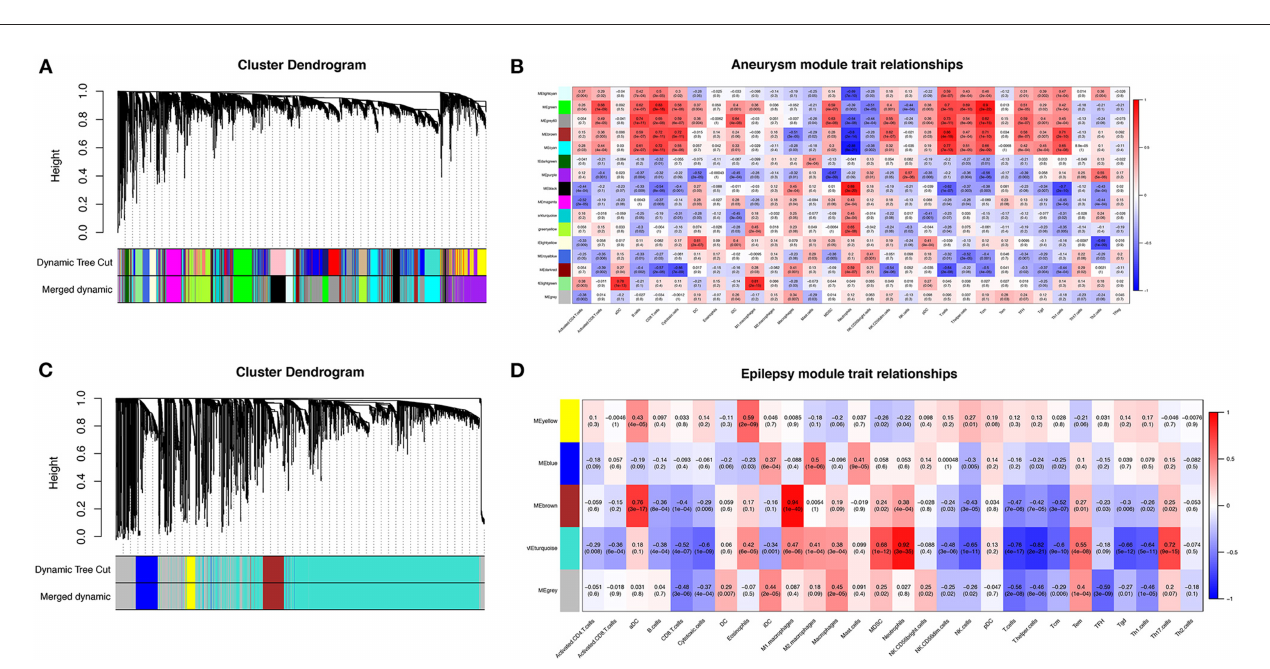
FIGURE7 Weighted gene co-expression network analysis (WGCNA). (A) Cluster dendrogram of co-expression genes in SAH. (B) Module–trait relationships in SAH. Each cell contains the corresponding correlation and P value. (C) Cluster dendrogram of co-expression genes in epilepsy. (D) Module–trait relationships in epilepsy. Each cell contains the corresponding correlation and P value. SAH, subarachnoid